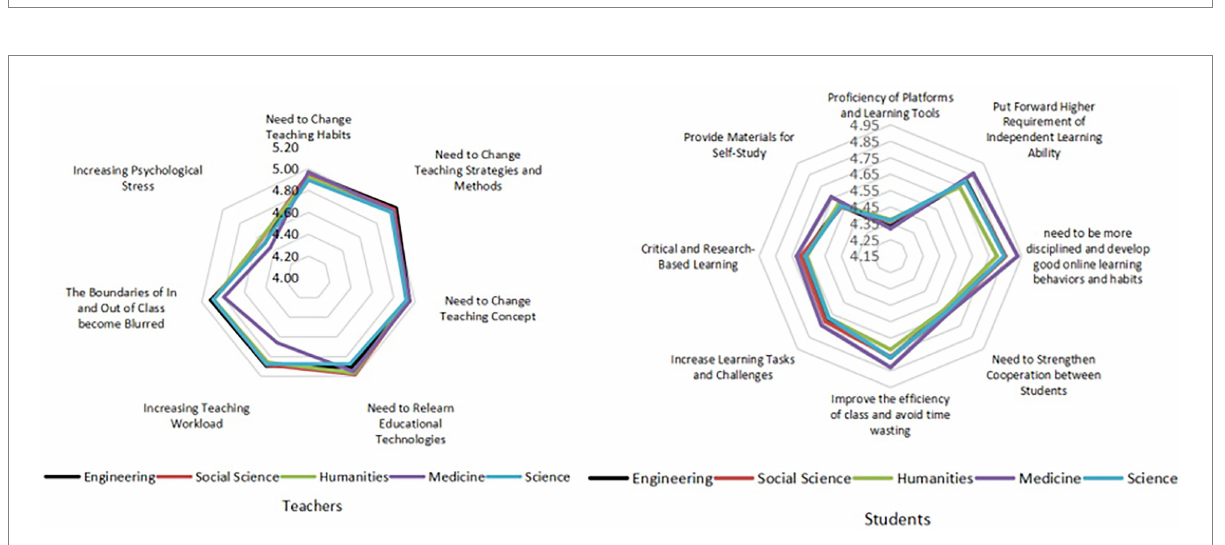
FIGURE 7 The biggest obstacle faced by teachers from different disciplines in online education.